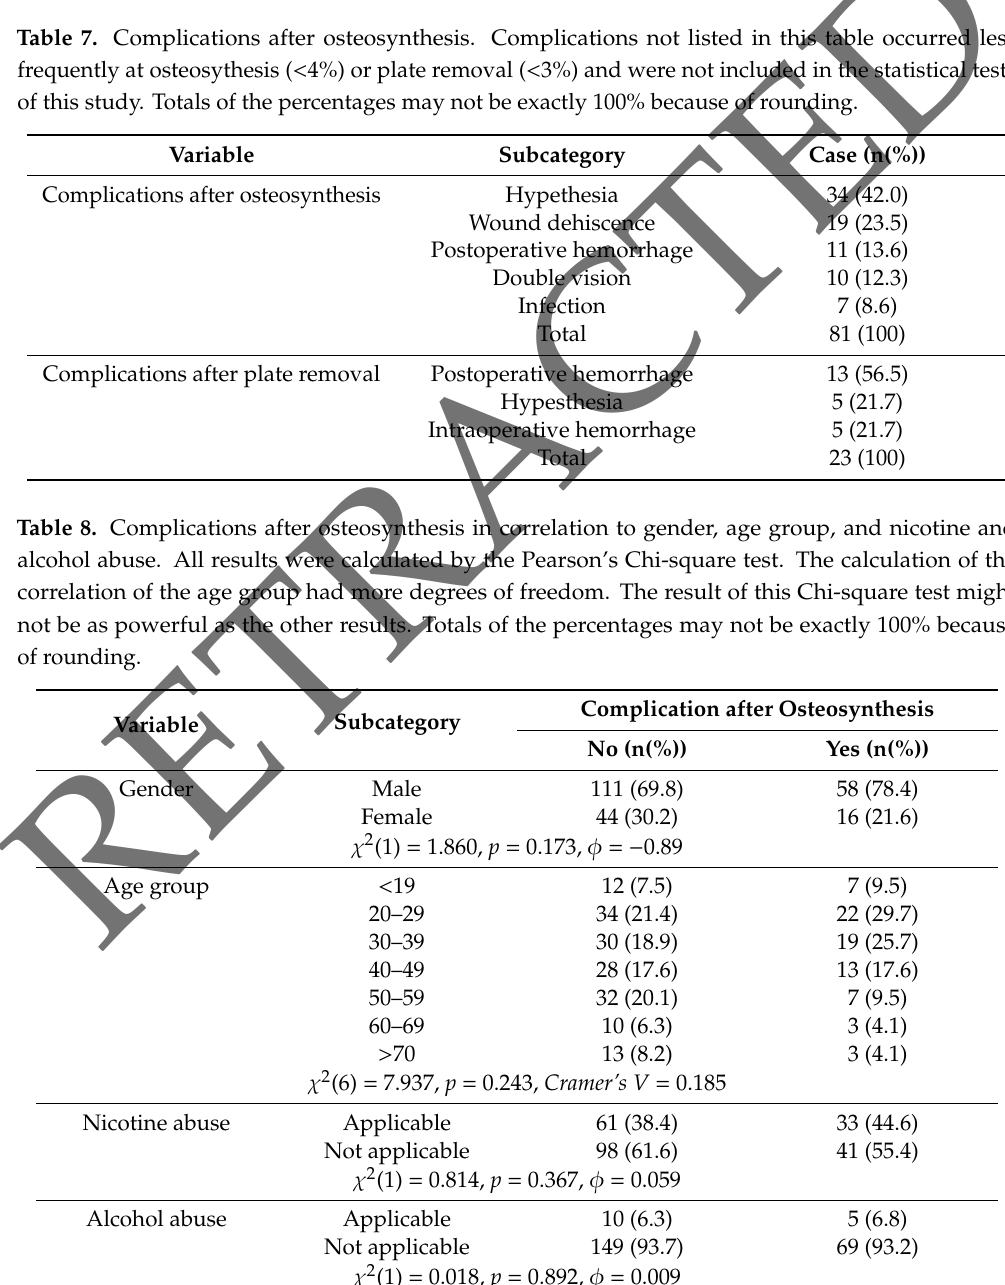
Table 7. Complications after osteosynthesis. Complications not listed in this table occurred less frequently at osteosythesis ( < 4%) or plate removal ( < 3%) and were not included in the statistical tests of this study. Totals of the percentages may not be exactly 100% because of rounding.